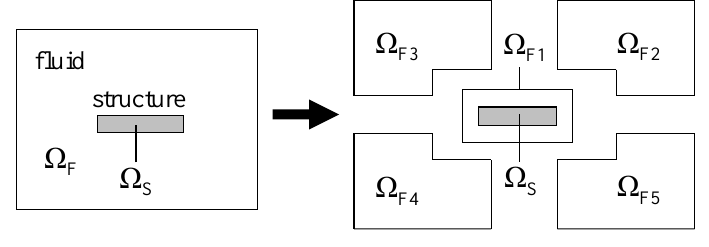
Figure 2. Mesh decomposition.